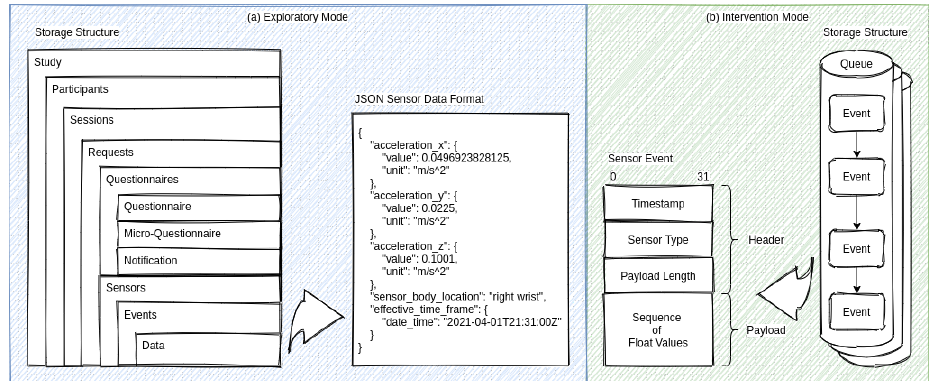
Figure 4. This figure displays the storage structures and data formats used in the two data collection modes. The data schema used in exploratory mode ( a ) is either JSON specified in the OpenMobile- Health project or aligned with it. The data schema used in the intervention mode ( b ) is transmitted without a schema to reduce